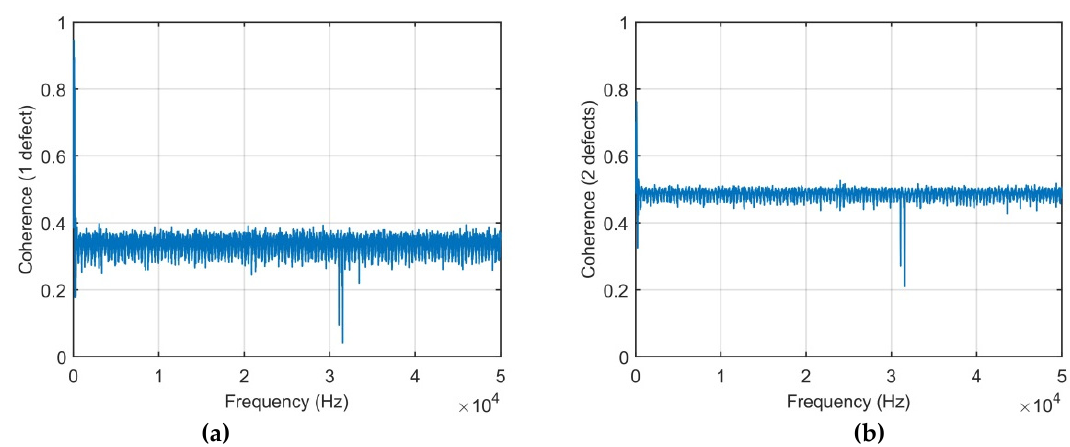
Figure 14. Coherence function: ( a ) One defect; ( b ) Two defects.